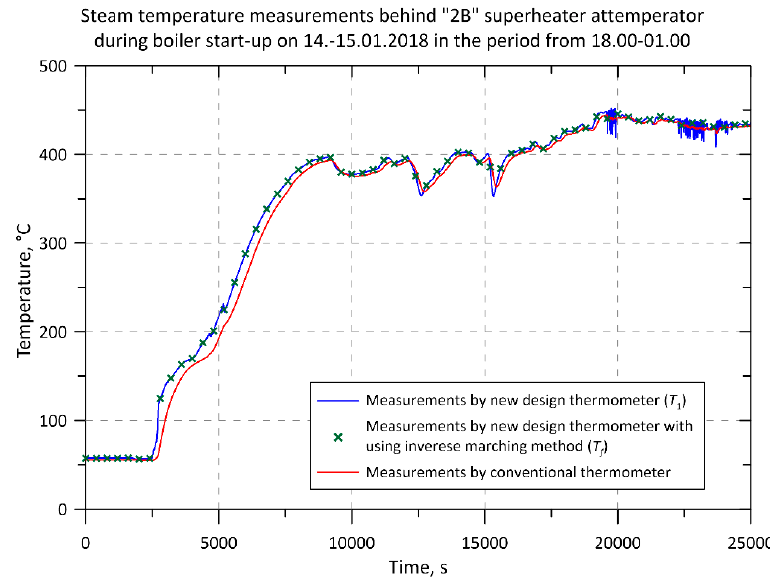
Figure 10. Comparison of thermometer’s indications located on side “A” during the start-up of the K8 boiler.